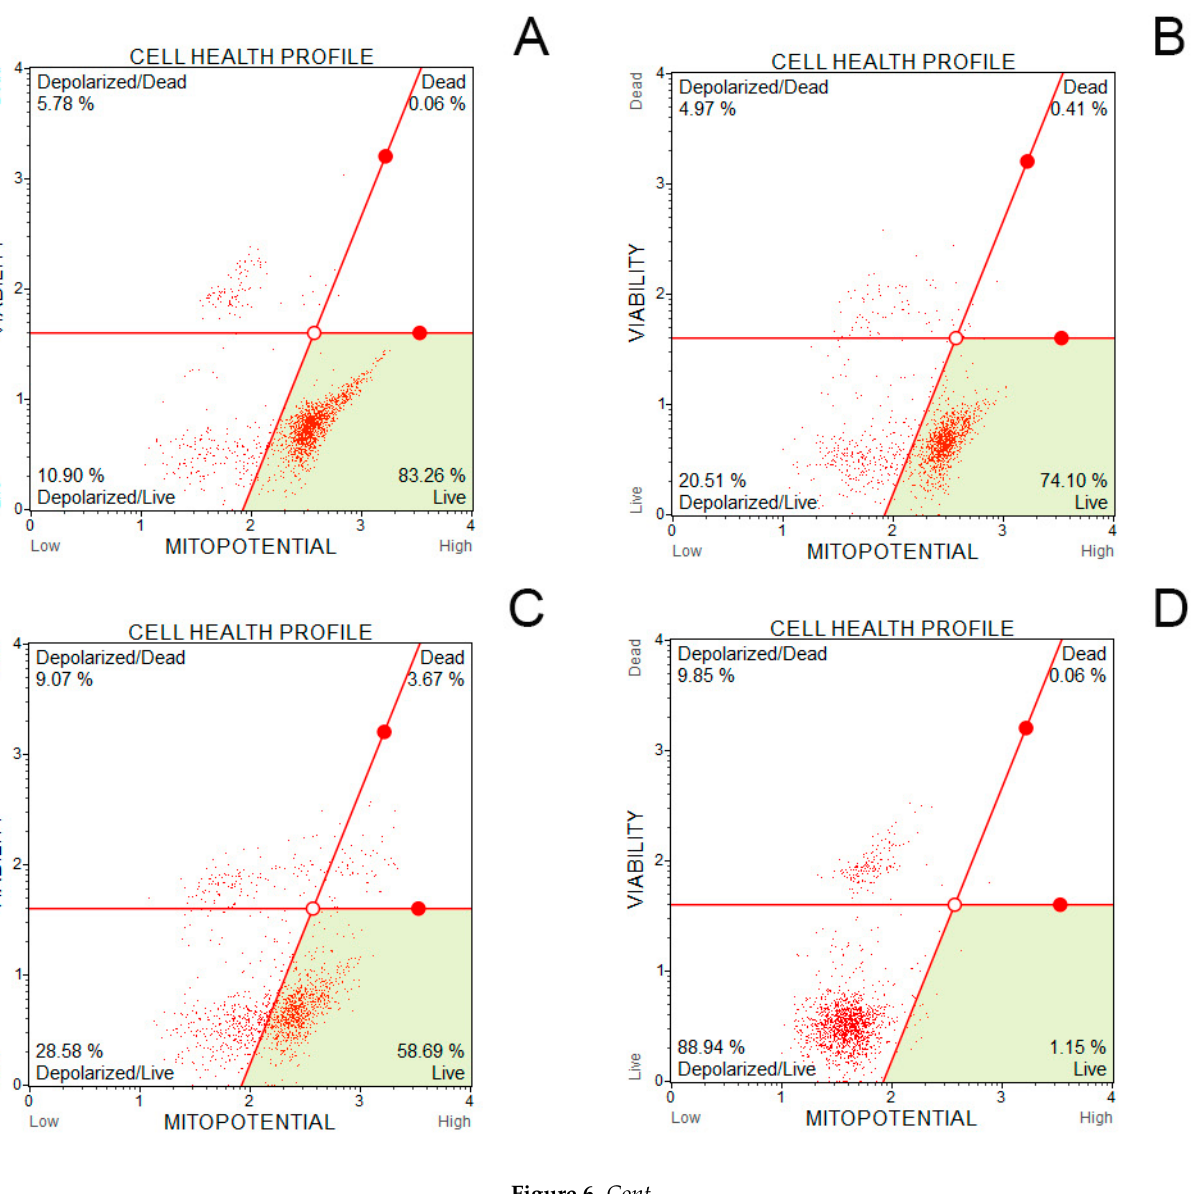
Figure 6. PIO decreases ΔΨ m in isolated intact thymocytes. ( A – D ) Typical plots obtained in the ab- sence of additions ( А , Control), in the presence of 50 ( B ) and 200 µM PIO ( С ), and 500 nM FCCP ( D ). ( E ) The portion of depolarized cells in different experimental groups (means ± SEM, n = 3). * Statistically significant ( p < 0.05) differences from control (without PIO). 2.7. Effect of PIO on ΔΨ m in Isolated Mitochondria and Mitochondria in Nuclei-Free Liver Homogenate In isolated mitochondria, PIO-dependent depolarization was transient (see Figures 1, 4 and 5): the higher the PIO concentration was, the higher the rate of the loss of the effect. Since PIO is poorly soluble in water, one can assume that, at high concentrations, PIO forms suspension, which decreases the effective concentration of PIO and deteriorates